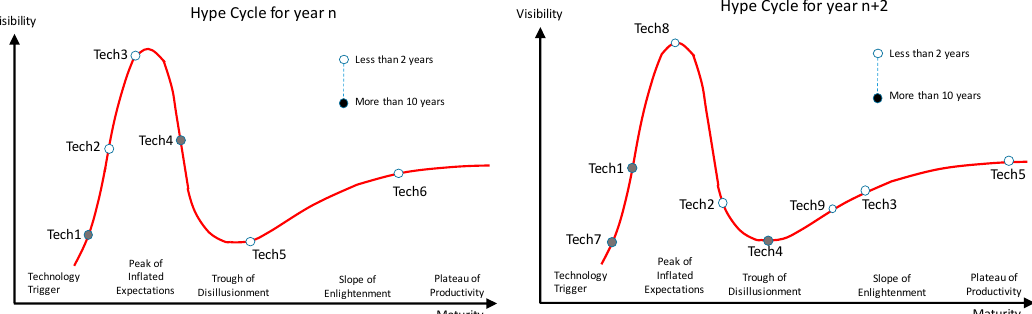
Figure 4. Characterisation of the hype cycle representation.